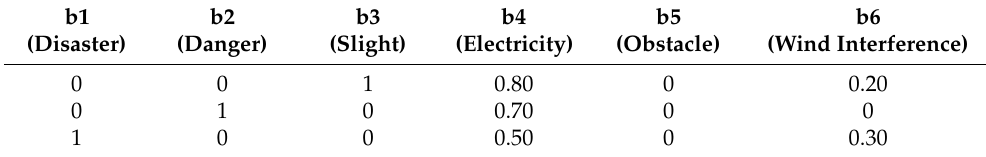
Table 7. Standardized real-time environment data under different health status of multirotor.